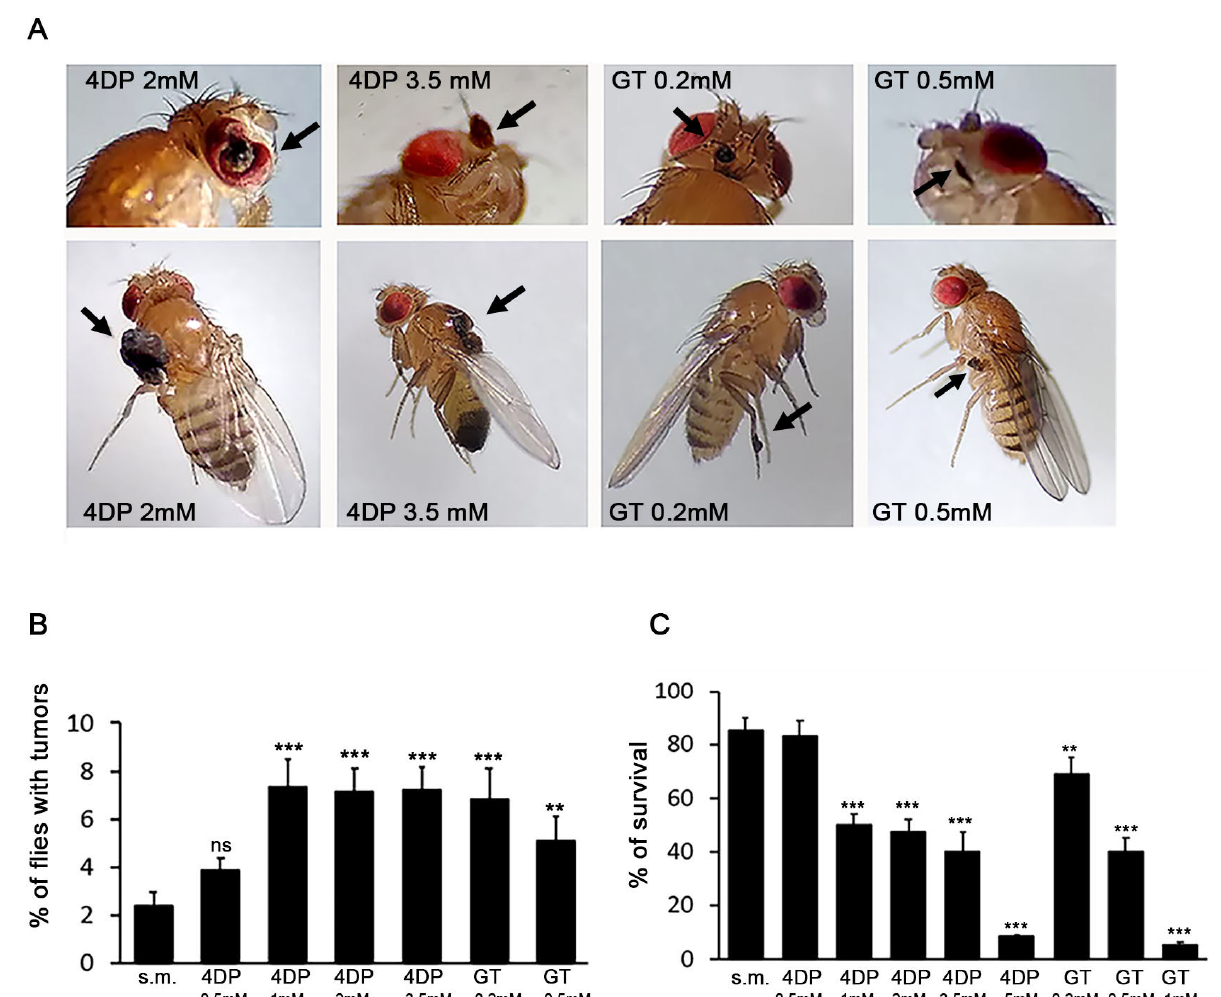
Figure 1. PLP inhibitors induce wts tumors . ( A ) Examples of wts tumors in wts/+ flies treated with different concentrations of PLP inhibitors (arrowed). ( B ) Quantification of the results. Each column represents the mean value ± SEM. For each condition, 300–700 flies from three different experiments were examined. ( C ) Percentage of flies reaching the adult stage. Each column represents the mean value ± SEM. For each condition, about 500 flies from three different experiments were examined.